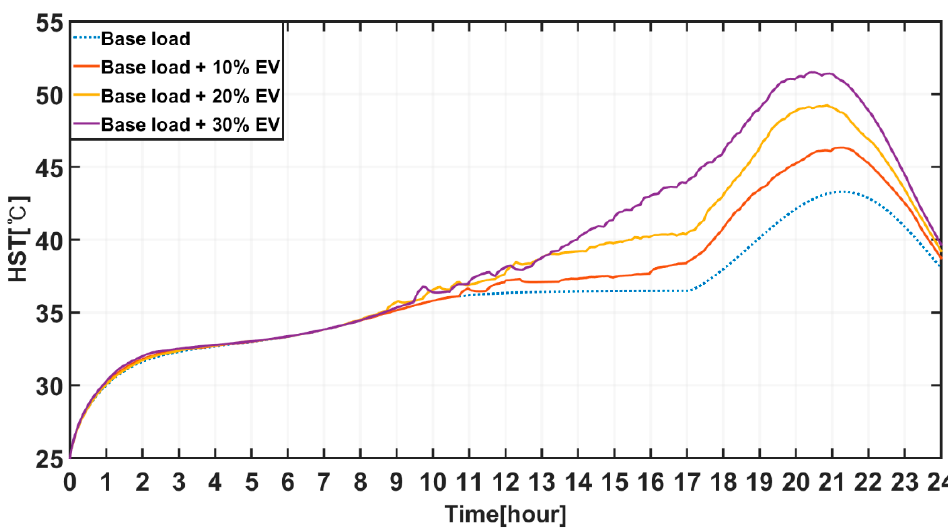
Figure A4. HST profile with di ff erent EV penetration ratios.